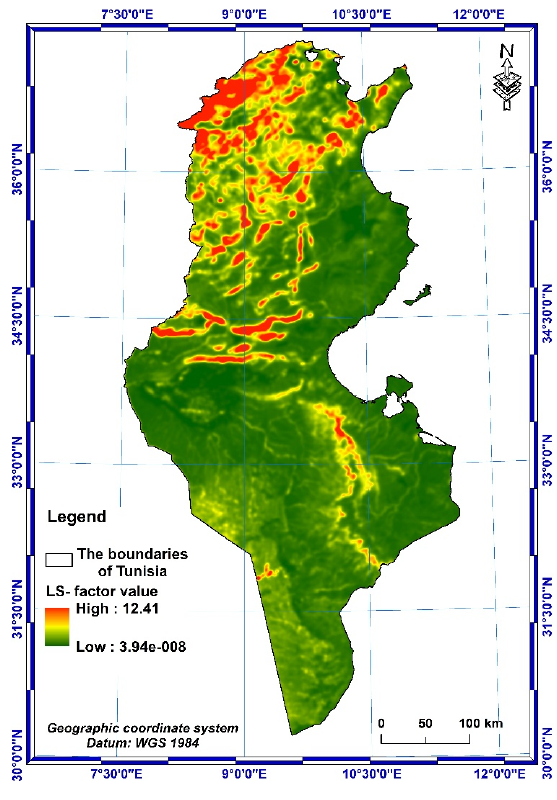
Figure 10. LS-factor spatial distribution.